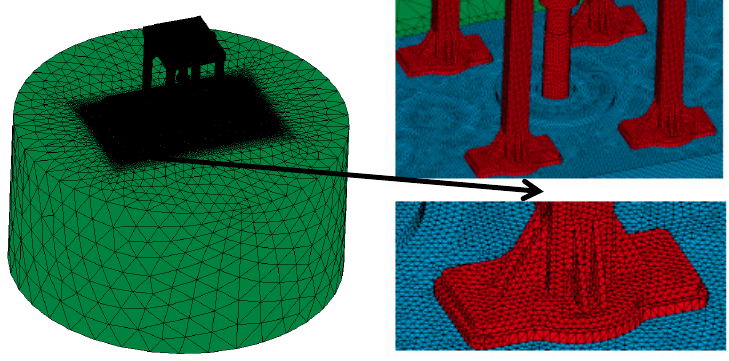
Figure 5. Vibrator geogrid. Table 1. Material parameters of the vibrator model.